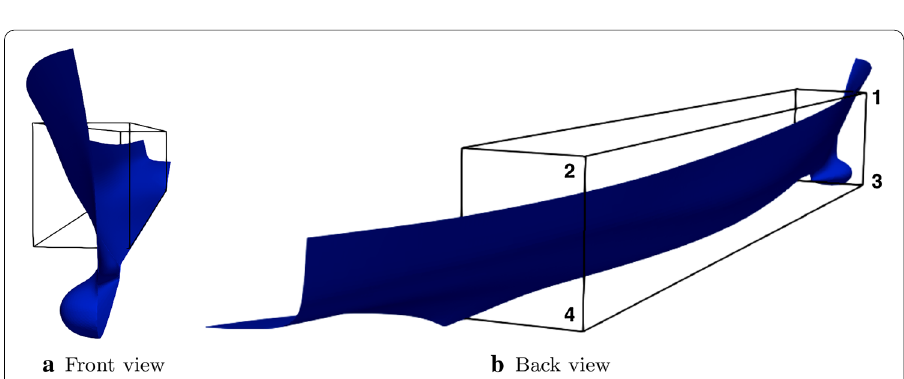
Fig. 5 FFD morphing on a simple geometry: the sphere case. Here we move only one FFD control point in the